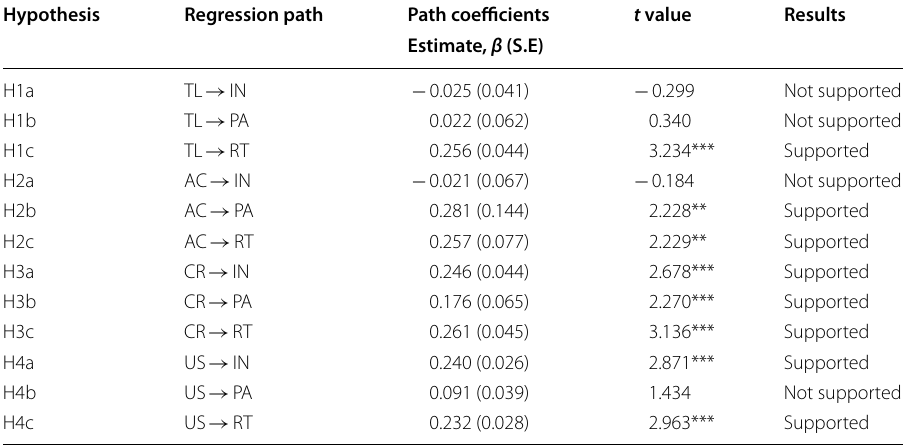
Table 6 Influence of market information quality on entrepreneurial orientation